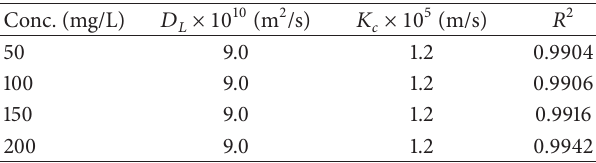
Table 8: Values of liquid phase diffusivity and mass transfer coefficient obtained by